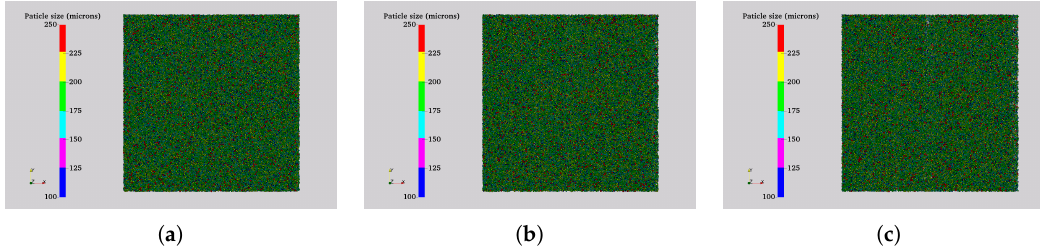
Figure 4. Sampling regions for the characterization of the spread layer for spreader speeds ( a ) U = 100 mm/s and ω = − 5 rad/s ( b ) U = 100 mm/s and ω = 0 ( c ) U = 100 mm/s and ω = 5